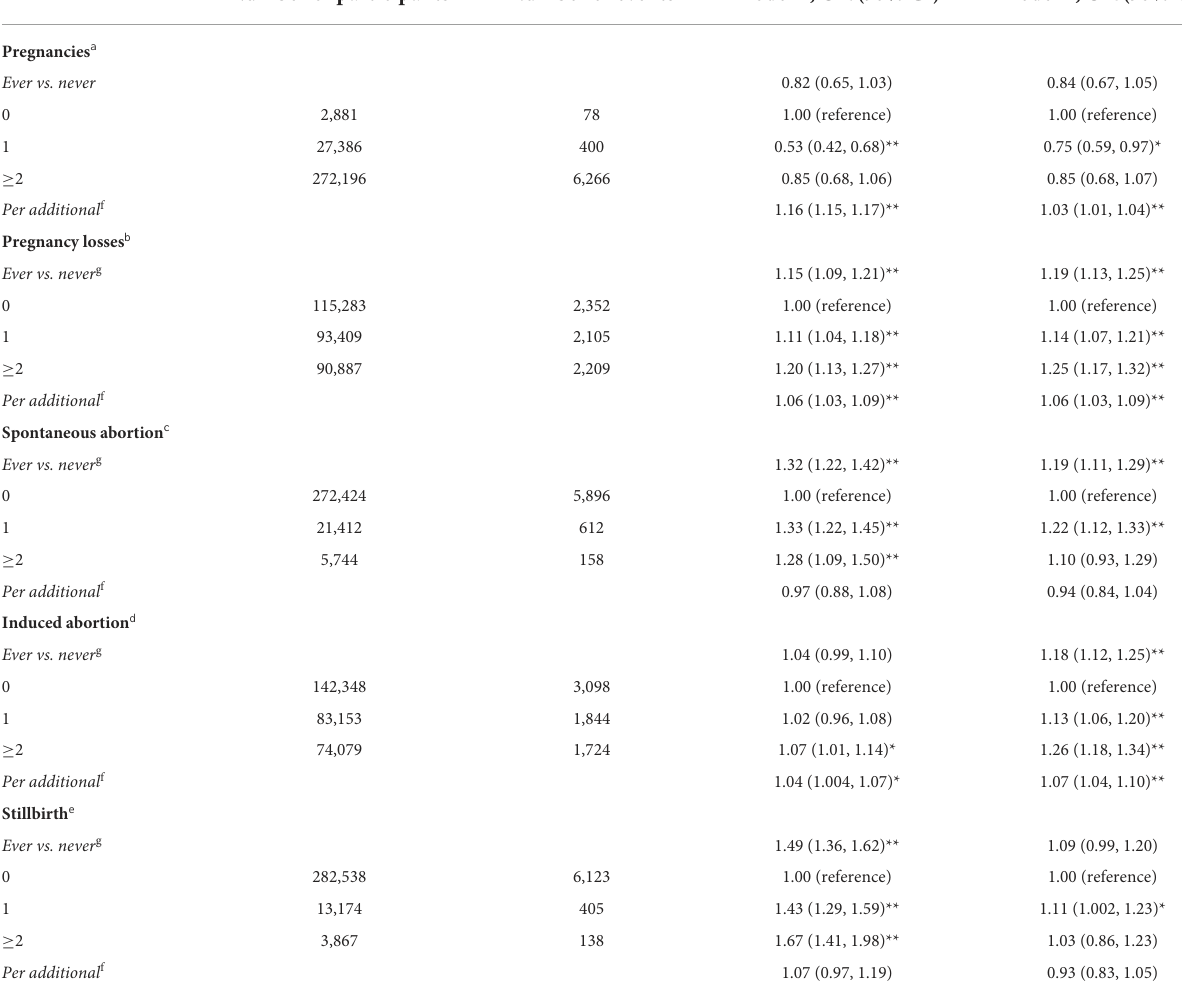
TABLE 2 Adjusted odds ratios (95% confidence intervals) for COPD risk associated with number of pregnancies and pregnancy losses. Number of participants Number of events Model 1, OR (95% CI) Model 2, OR (95%